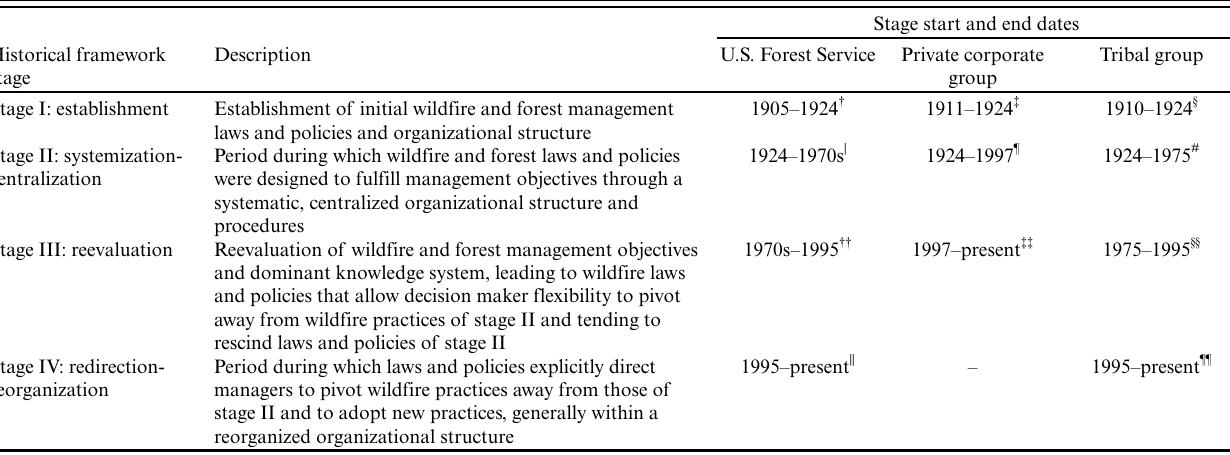
Table 1. Coupled human and natural system-historical framework of wildfire management in frequent-fire forest among large forest ownerships.